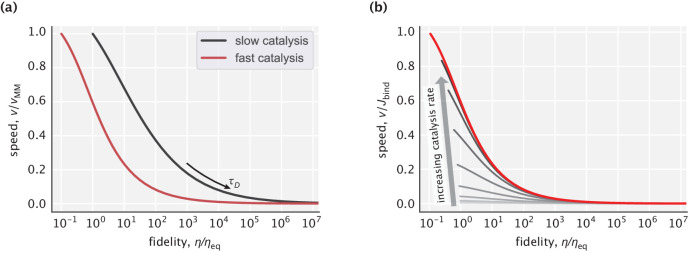
Pareto front of the speed–fidelity trade-off at different levels of catalytic activity.(a) Cases of slow and fast catalysis limits, with the y-axis for speed normalized to the [0,1] interval. (b) Family of Pareto fronts for different choices of the catalysis rate. Speed on the y-axis is reported relative to the substrate binding flux Jbind.